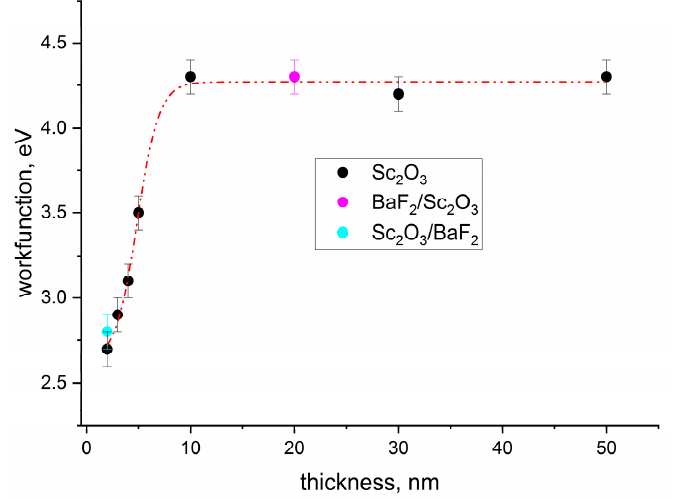
Figure 13. Plot of the work function values as a function of the thickness and the interpolation curve (red line) for both the Sc 2 O 3 and the double-layer (with BaF 2 ) fi lms.